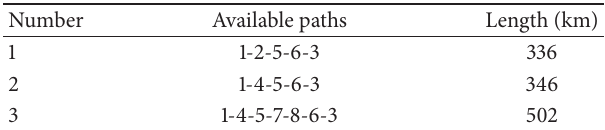
Figure 3. Eight stations and six segments are in the